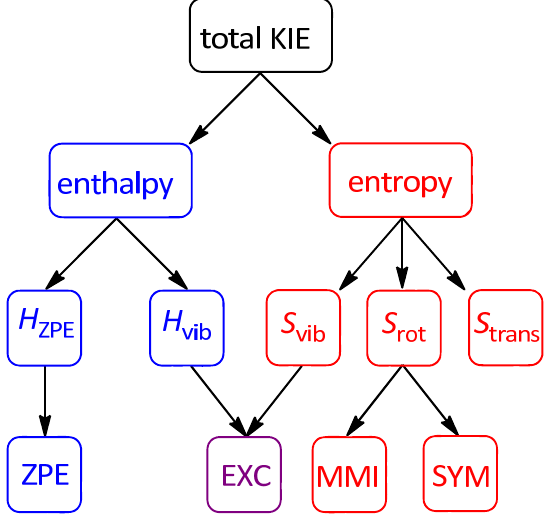
Figure 2. Flowchart illustrating a KIE partitioning into enthalpy and entropy contributions, and their relationship to the Bigeleisen-Mayer ZPE, EXC, MMI, and SYM